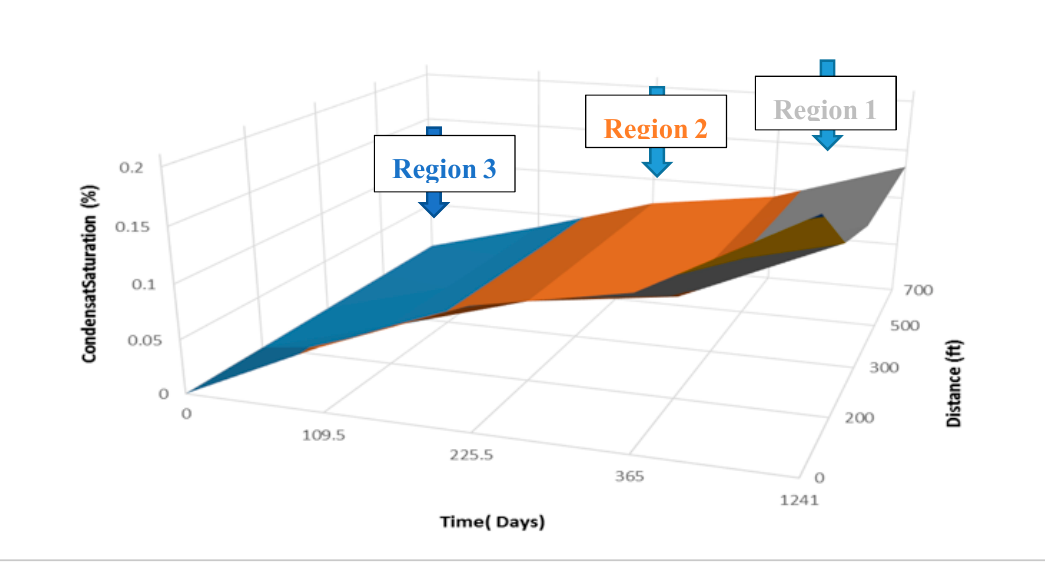
Figure 10. 3D evaluation of condensate formation against production time and distance from the wellbore.